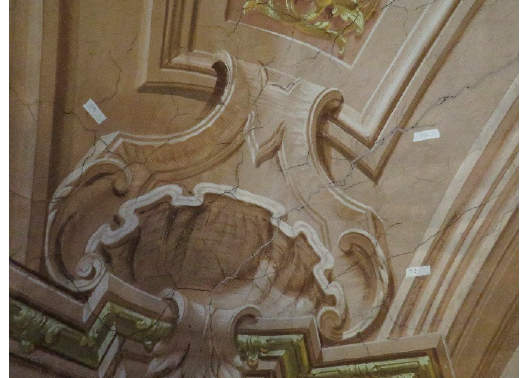
Figure 7. Survey area on the Pelagi room vault.